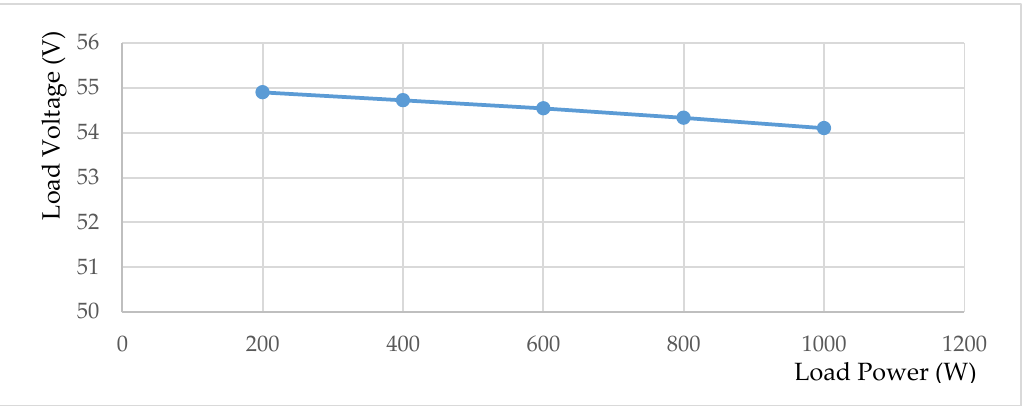
Figure 24. DC – DC converter load voltage-power characteristics at V in = 400 V. Figure 24. DC–DC converter load voltage-power characteristics at V in = 400 V.